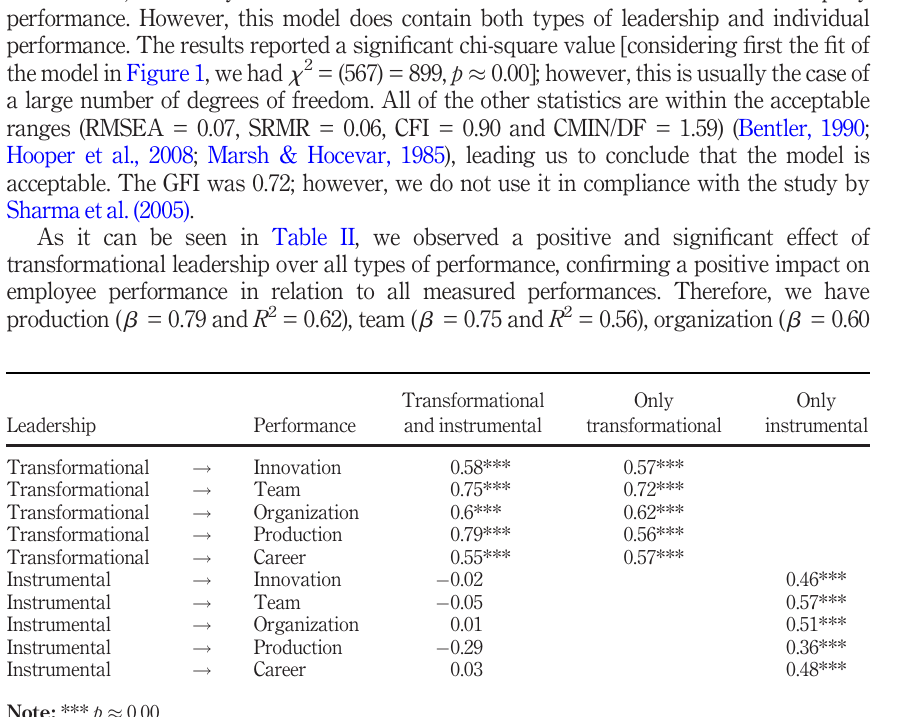
Table II. Models 1, 2 and